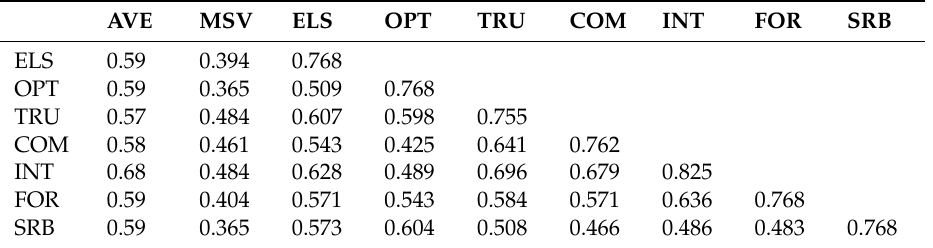
Table 3. Validating the measurement of CFA